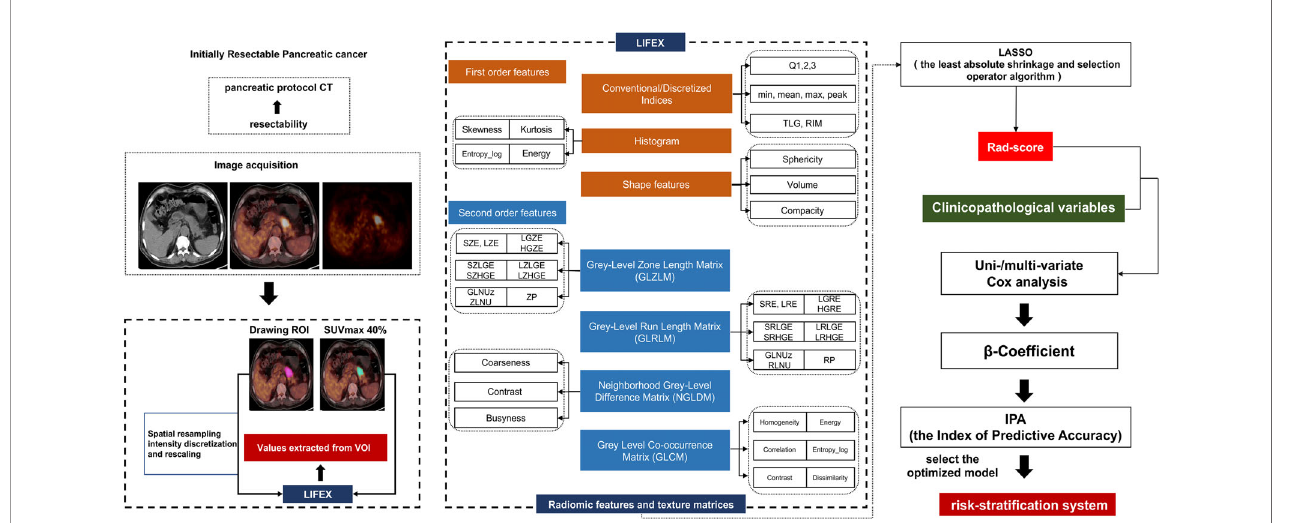
FIGURE 1 | Flowchart of patient selection, radiomic features extraction and strati fi cation system